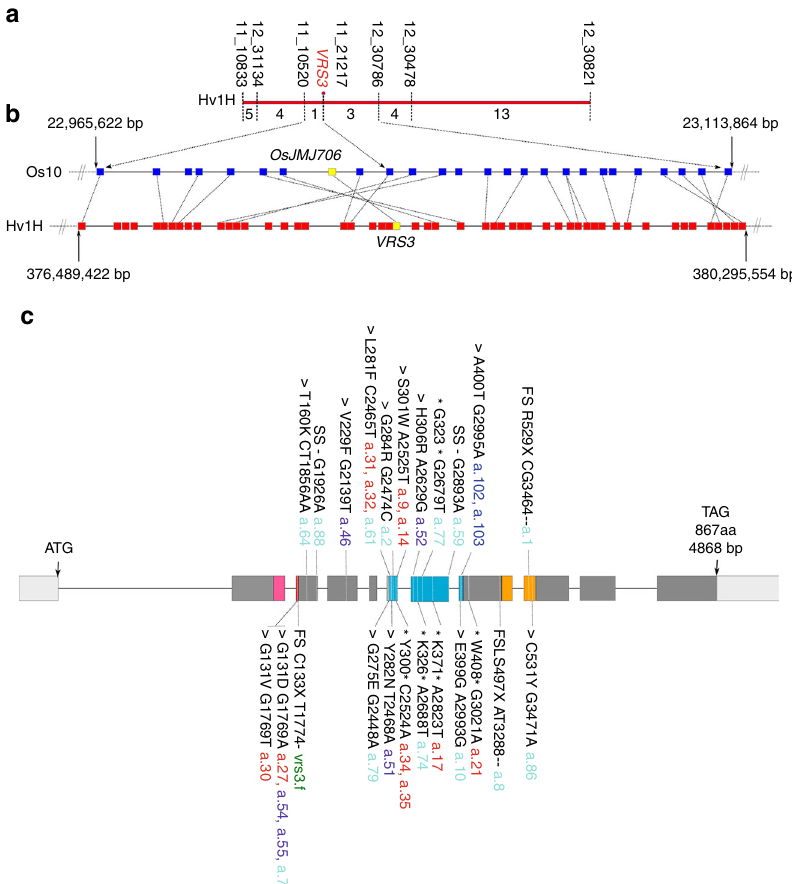
Fig. 2 Identi fi cation of VRS3 . a The re fi ned genetic mapping interval of the vrs3 locus showing the number of recombinants between each marker. b Conserved synteny between orthologous regions on the physical maps of rice chromosome 10 and barley chromosome 1H within the genetic mapping interval. Rice gene models are shown in dark blue and barley in red. The yellow square represents the VRS3 gene candidate. c VRS3 gene model with regions encoding three putative functional domains JmjN (pink), JmjC (turquoise) and C5HC2 zinc- fi nger (orange). The 5 ′ and 3 ′ untranslated regions are shown in pale grey. Positions of the mutant alleles are relative to the start codon (ATG). Allele colours represent the respective genetic background of the induced mutation: turquoise (Bonus), green (Hakata 2), dark blue (Hege), red (Foma), and purple (Kristina). Types of mutation are coded as: > non-synonymous substitution, *premature stop, FS, frameshift, SS, splice